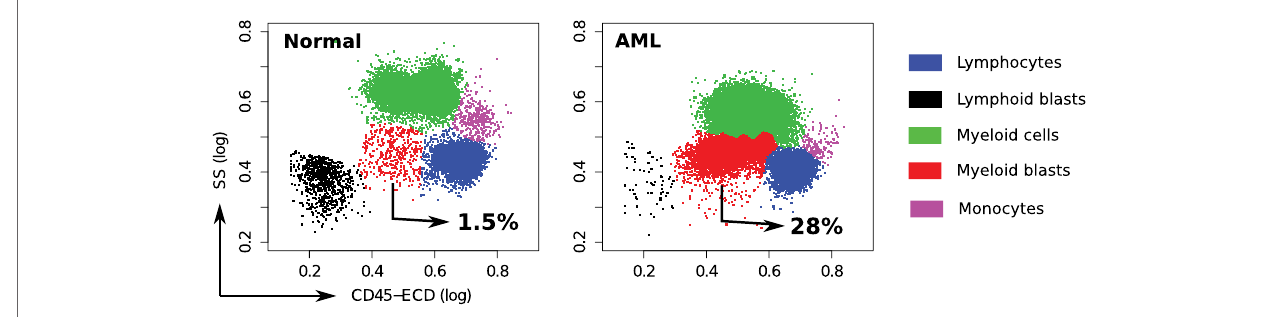
FigUre 11 | cell types identified on the side scatter (ss) and cD45 channels for a healthy and an aMl-positive sample . Cell populations are discovered in the seven-dimensional samples with the clustering algorithm and then projected on these channels for visualization. A pair of clusters denoting the same cell type is marked with the same color. The proportion of myeloid blast cells (shown in red) increases significantly in the AML